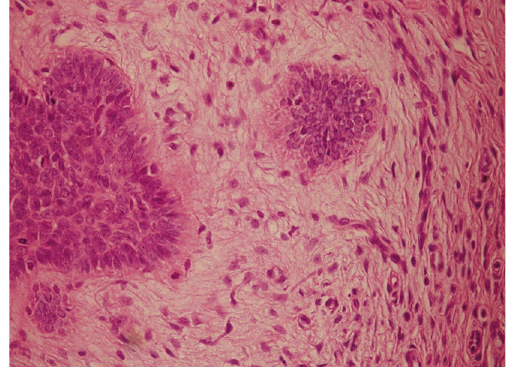
Figure 2: Large magnification showing the intersection area of the normal dermis stroma and the stroma caused by the tumor on the right, and the typical palisadic arrangement of the cells on the peripheral tumor on the left (H and E stain; original magnification: